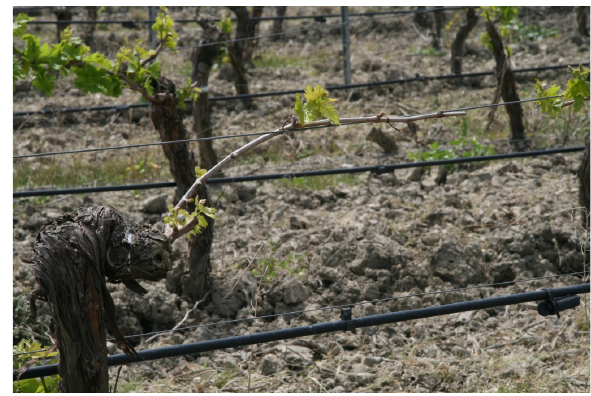
Fig. 1. Retarded growth and spur dieback in 13-year-old vines cv. Insolia infected with Lasiodiplodia theobromae.